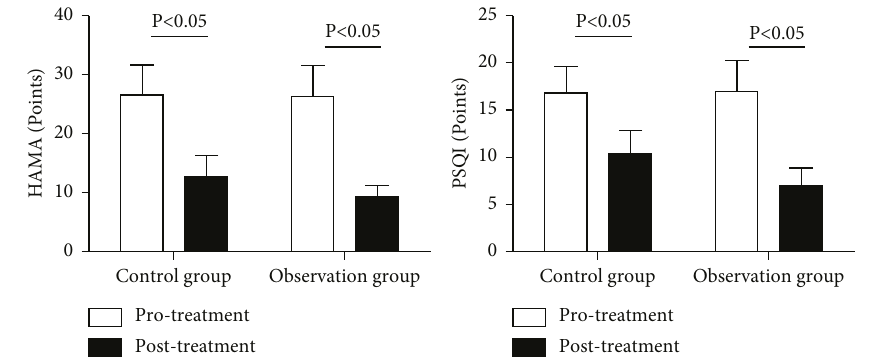
Figure 2: Changes in HAMA and PSQI scores before and after treatment in the two groups. Table 3: Comparison of medication compliance between two groups of patients ( n ,